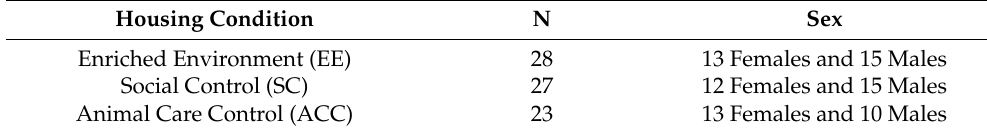
Table 1. Experimental